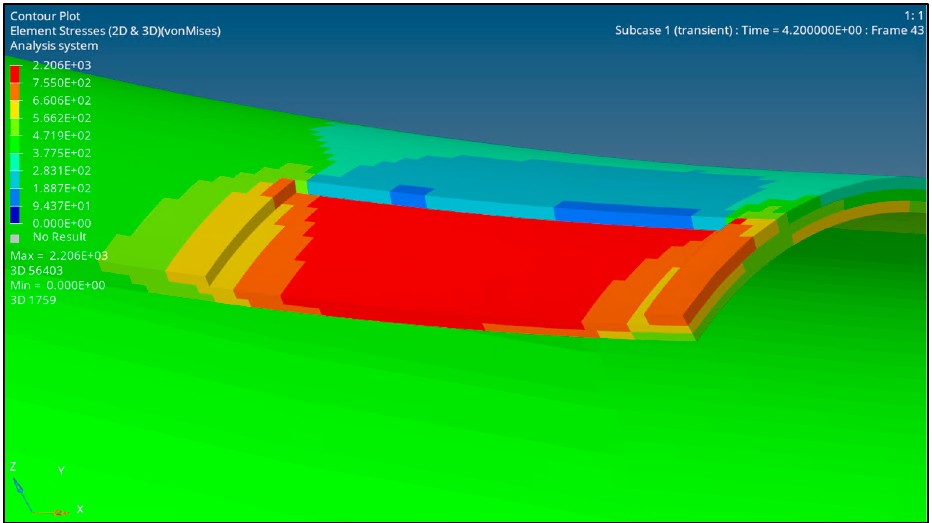
Figure 5. Red contour depicting the pipe component’s failure region.